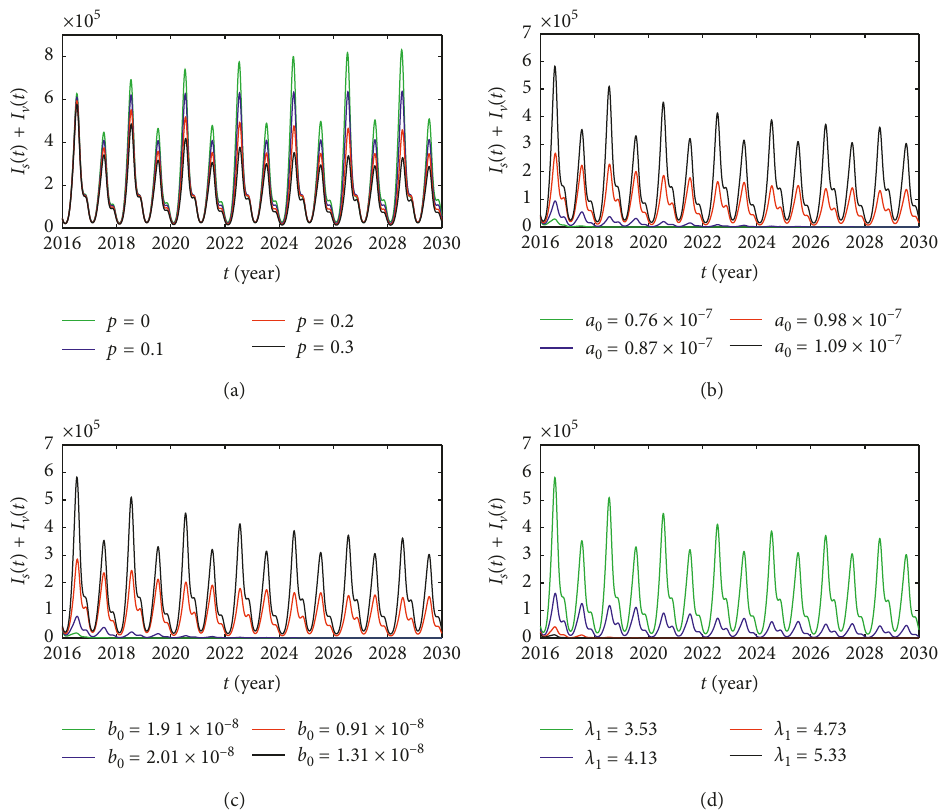
Figure 9: The influence of parameters on symptomatic infectious individuals I ; (c) versus b , being the baseline contact rate of β rate of β 0 1 conditions are the same as in Figure 3.